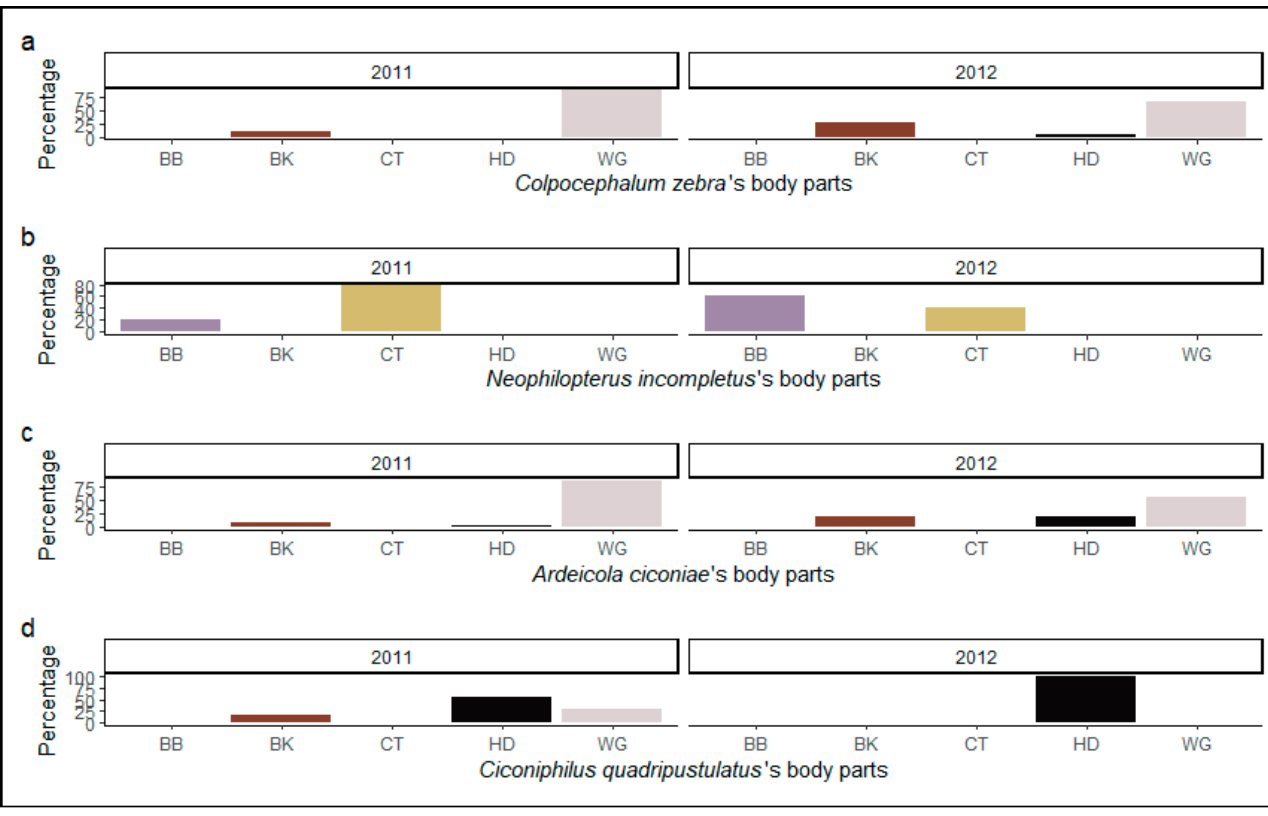
Figure 3. Frequency and spatial distribution of ( a ) Colpocephalum zebra ; ( b ) Neophilopterus incompletus ; ( c ) Ardeicola ciconiae; ( d ) Ciconiphilus quadripustulatus on five body parts of white stork nestlings in 2011 and 2012. BB, breast and belly; BK, back; CT, crissum and tail; HD, head; WG, wings.